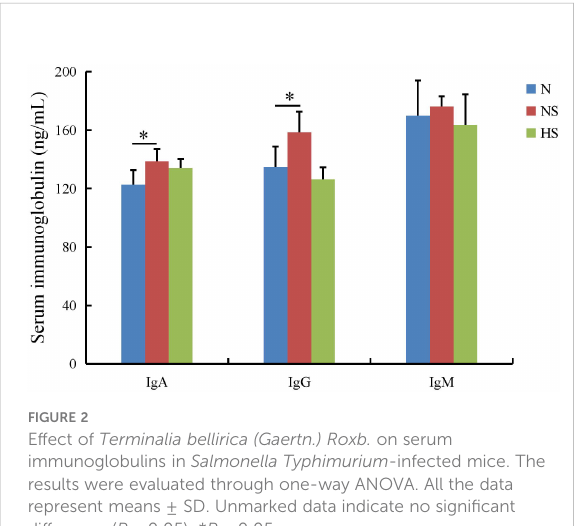
FIGURE 2 Effect of Terminalia bellirica (Gaertn.) Roxb. on serum immunoglobulins in Salmonella Typhimurium -infected mice. The results were evaluated through one-way ANOVA. All the data represent means ± SD. Unmarked data indicate no signi fi cant difference ( P > 0.05); * P < 0.05.